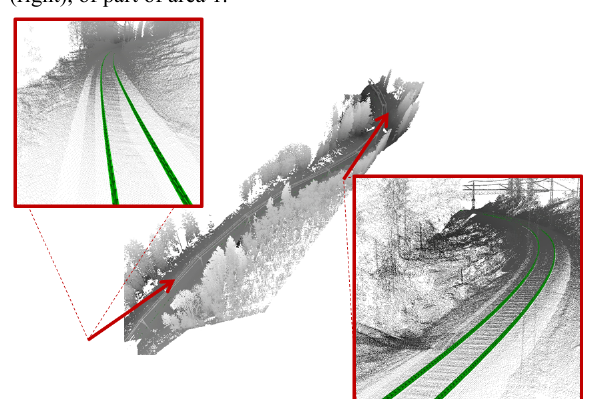
Figure 11. 3D models overlaid on points from area 2.